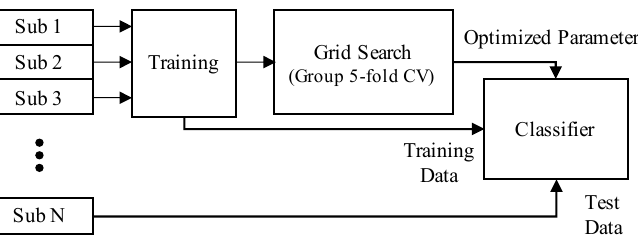
Figure 6. Grid-search cross-validation scheme with leave-one-subject-out cross-validation (each fold). This was repeated as many as the number of subjects to test all subjects. Table 1. Parameter candidates for each classifier.